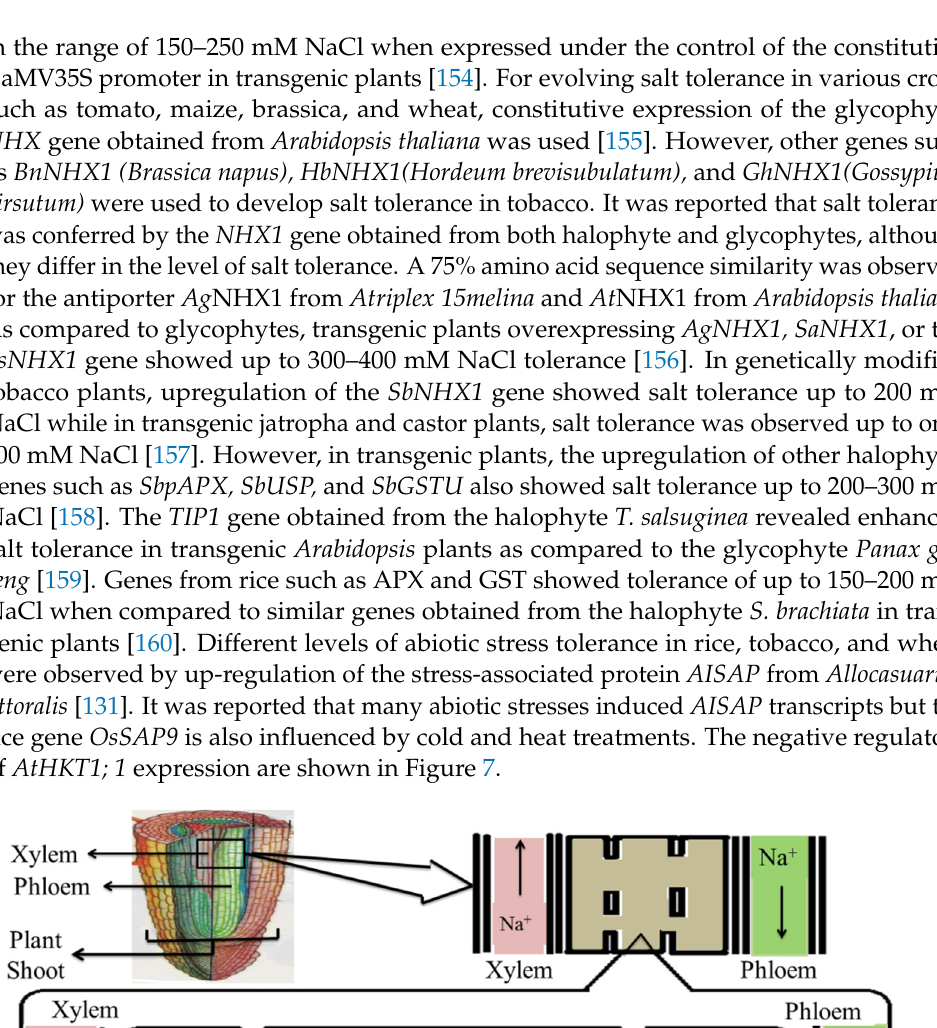
saline and arid areas for sustainable